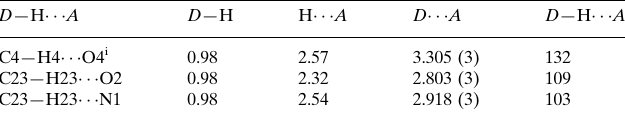
Hydrogen-bond geometry (A˚ , (cid:1)